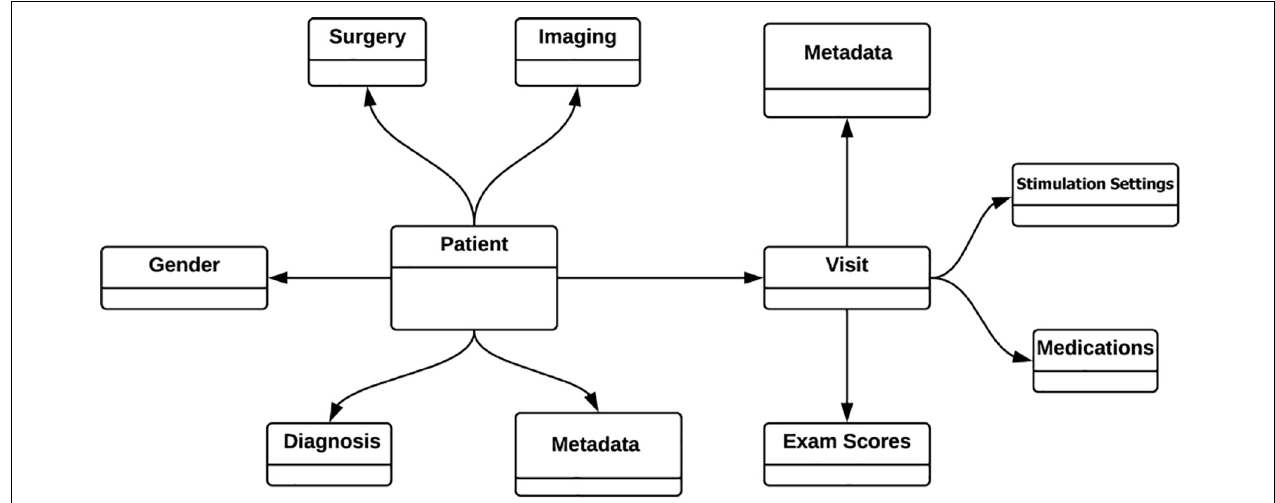
FIGURE 1 | Simplified INR data model. All the data is modeled around and tied directly to each individual patient. Patient visits to the clinician (“Visit”) is a growing list of visits, but only shown here as a single visit for simplicity. One strength of the graph database is that all information is entered according to relationships, eliminating the need for “join” operations between tabulated